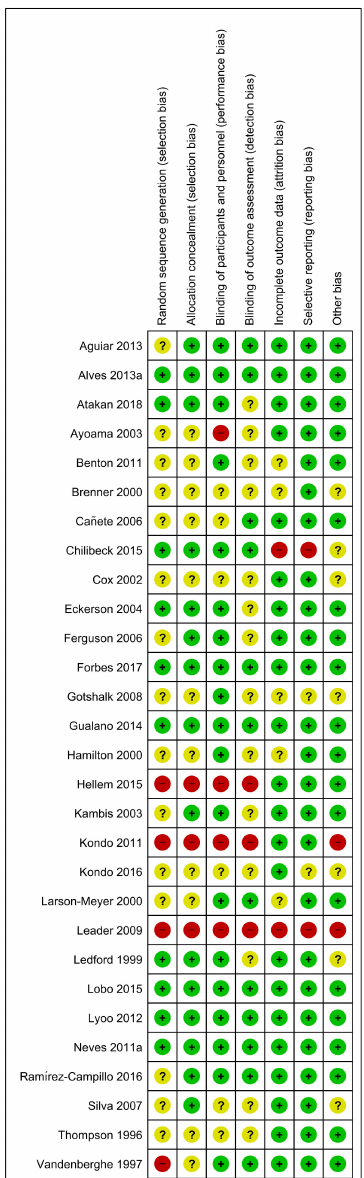
Figure 3. Individual risk of bias for included studies. Data are presented as risk assessment across 7 predefined domains. + (green) = low risk of bias, ? (yellow) = unclear risk of bias, - (red) = high risk of